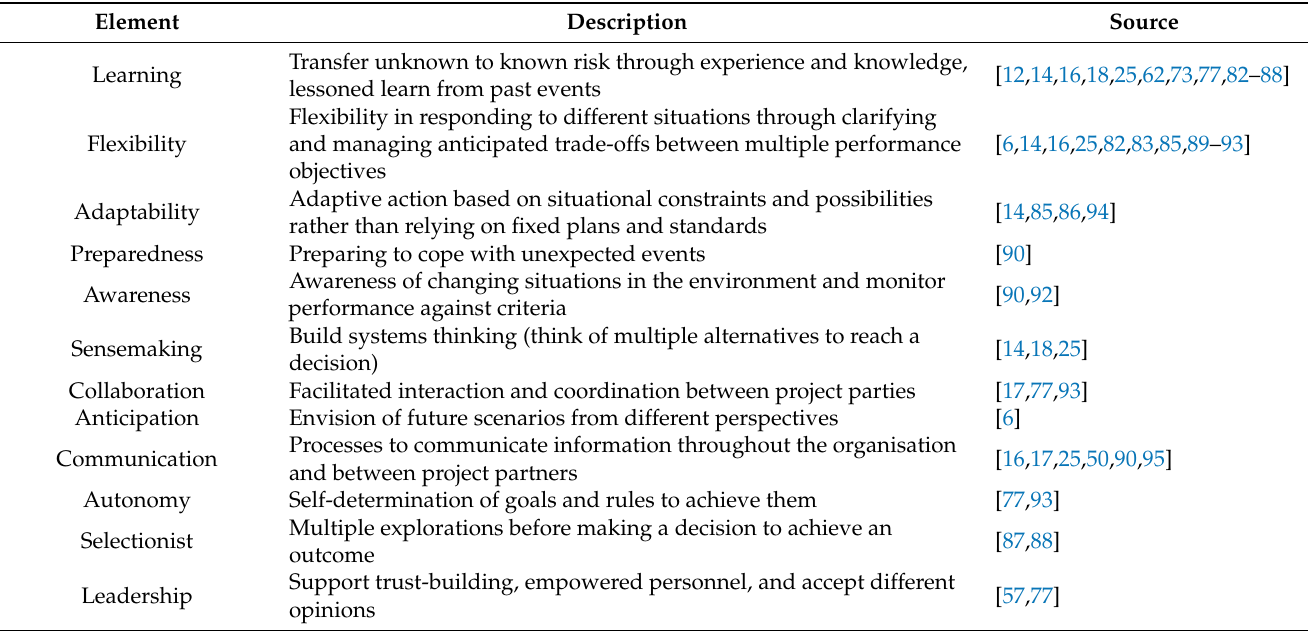
Table 2. The uncertainty management